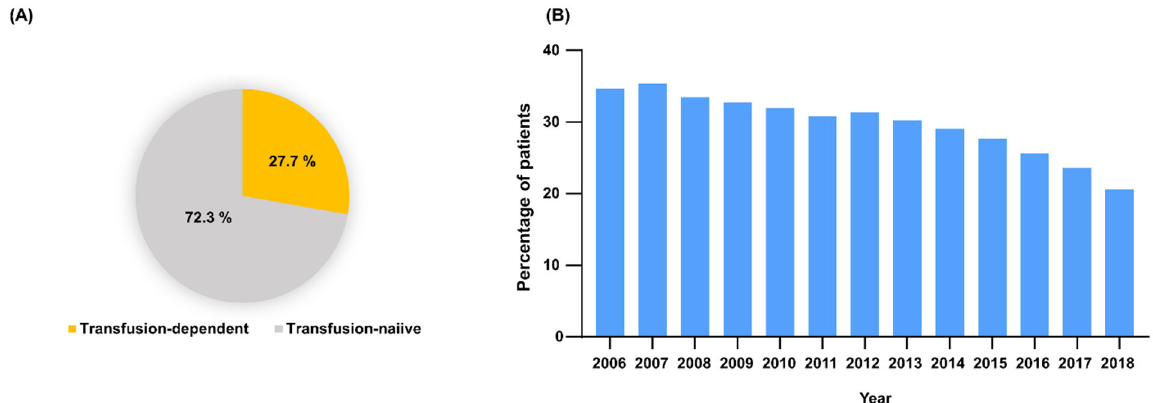
Figure 4. Blood transfusion in thalassemia. ( A ) Overall proportion of patients who received trans ‐ fusions from 2006 to 2017. ( B ) Trend since 2006 of the percentage of patients who received a blood transfusion during study period.